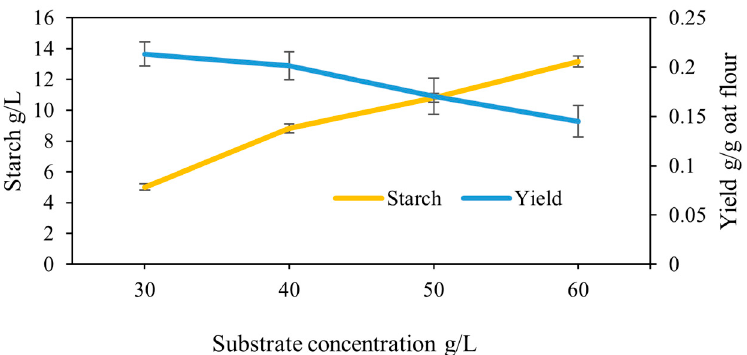
Figure 6. Profile of biomass yield, substrate concentration and starch consumption during growth of Aspergillus oryzae on oat flour in shake